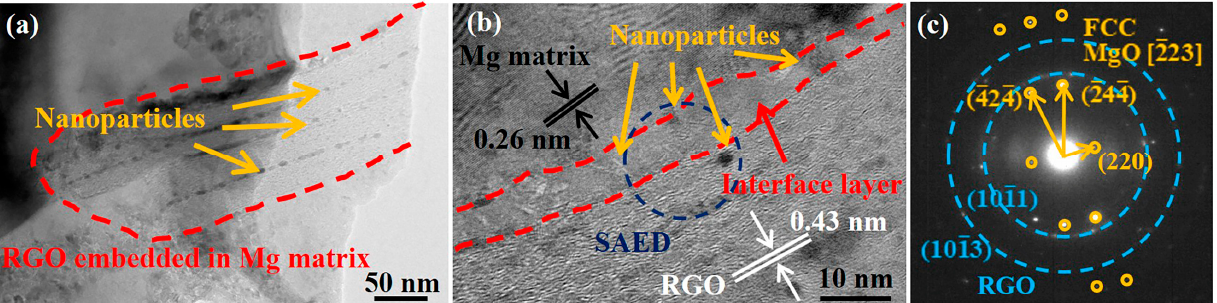
Figure 9. ( a ) RGO embedded in 0.6 wt.% RGO/ZK61 composite with nanoparticles distributed on the surface of RGO; ( b ) interfacial structure between RGO and magnesium matrix; and ( c ) selected area electron diffraction of the interface layer in ( b